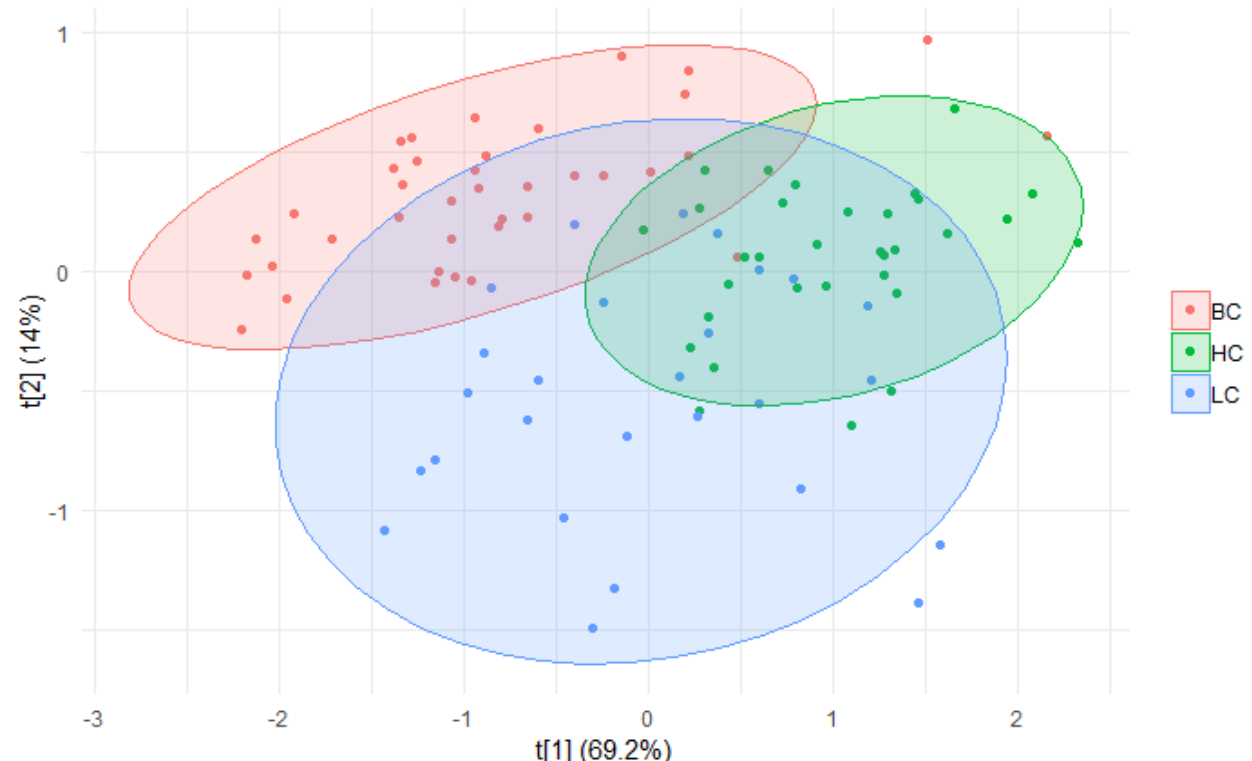
Figure 5. Principal component analysis (PC1 vs. PC2) score scatterplot of the hydrolyzed carbohydrates from the BC, LC, and HC samples.